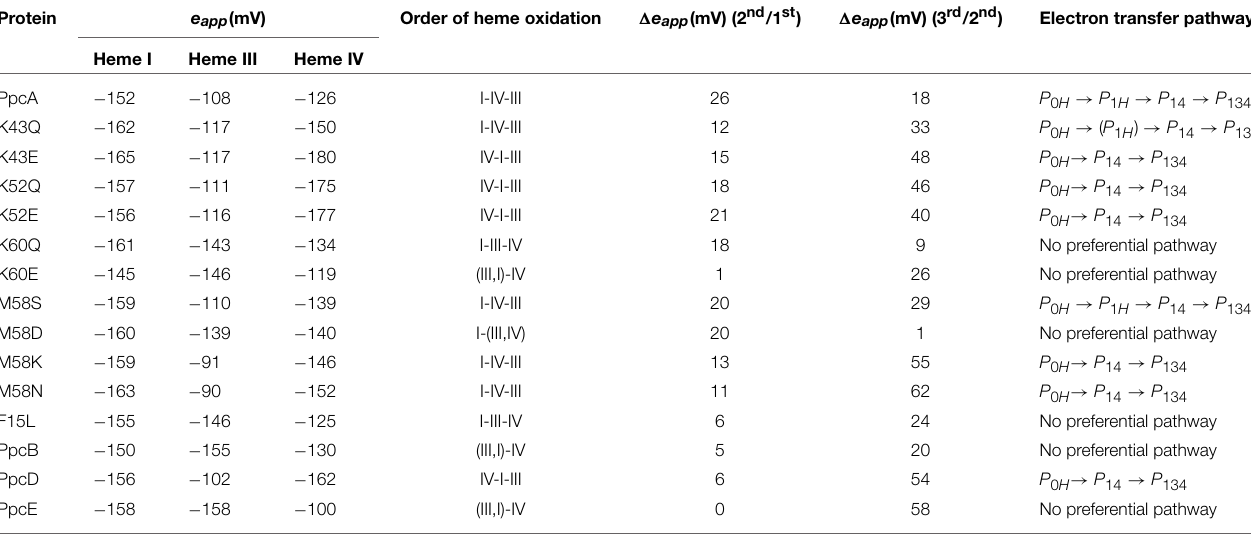
TABLE 4 | Comparison of the results obtained from the thermodynamic characterization of PpcA mutants at pH 7.5 (Dantas et al., 2012; Morgado et al., 2013, 2014). Protein e app (mV) Order of heme oxidation